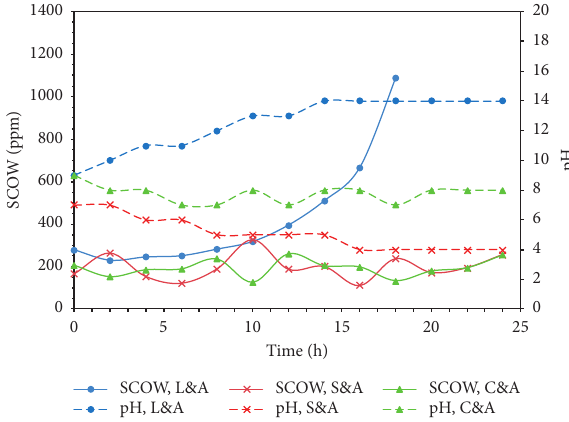
Figure 10: Variation of SCOW of different combinations with varying